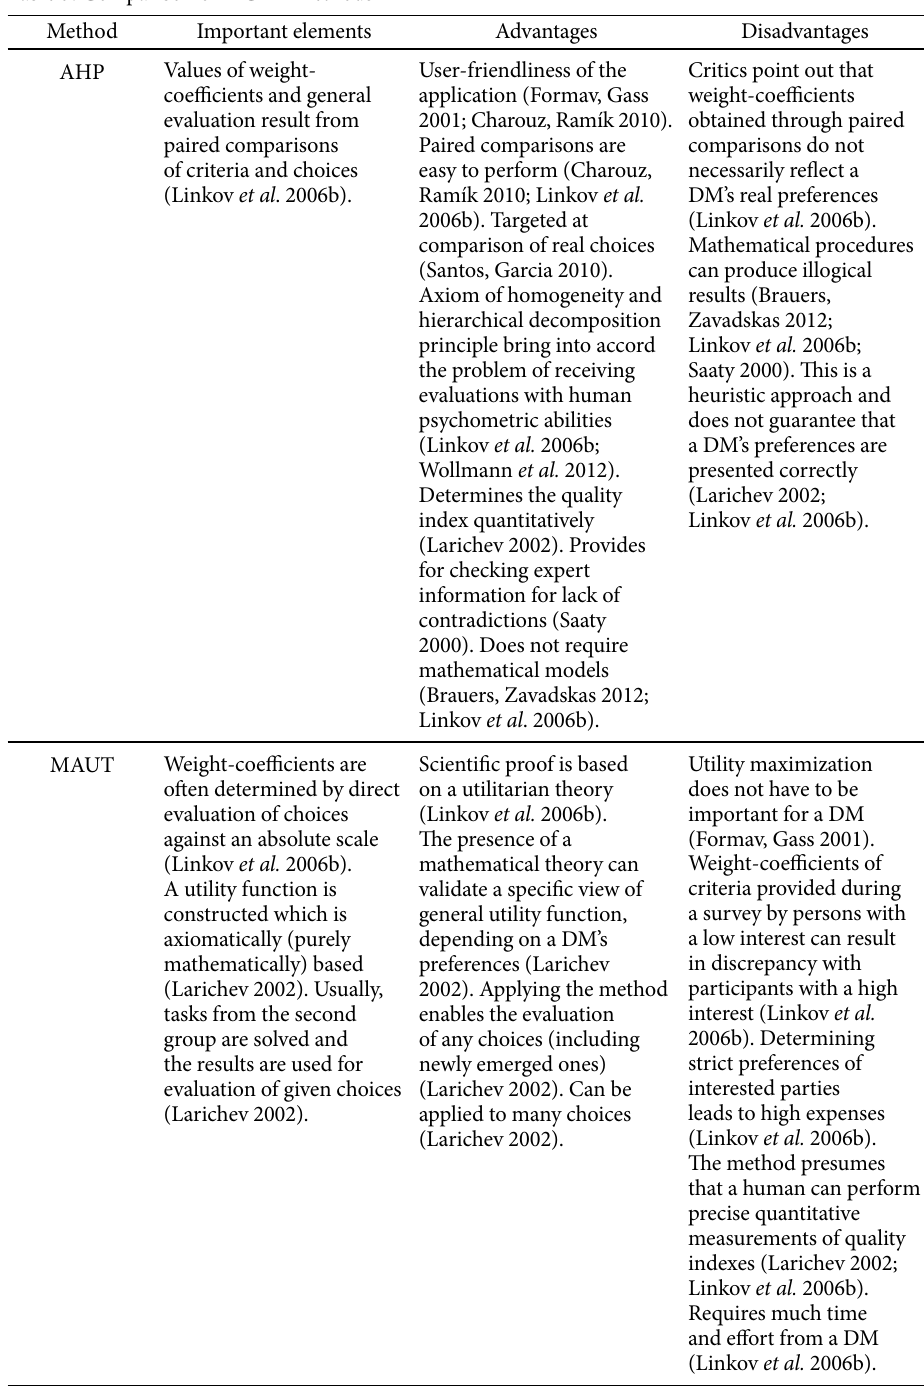
Table 3. Comparison of MCDA